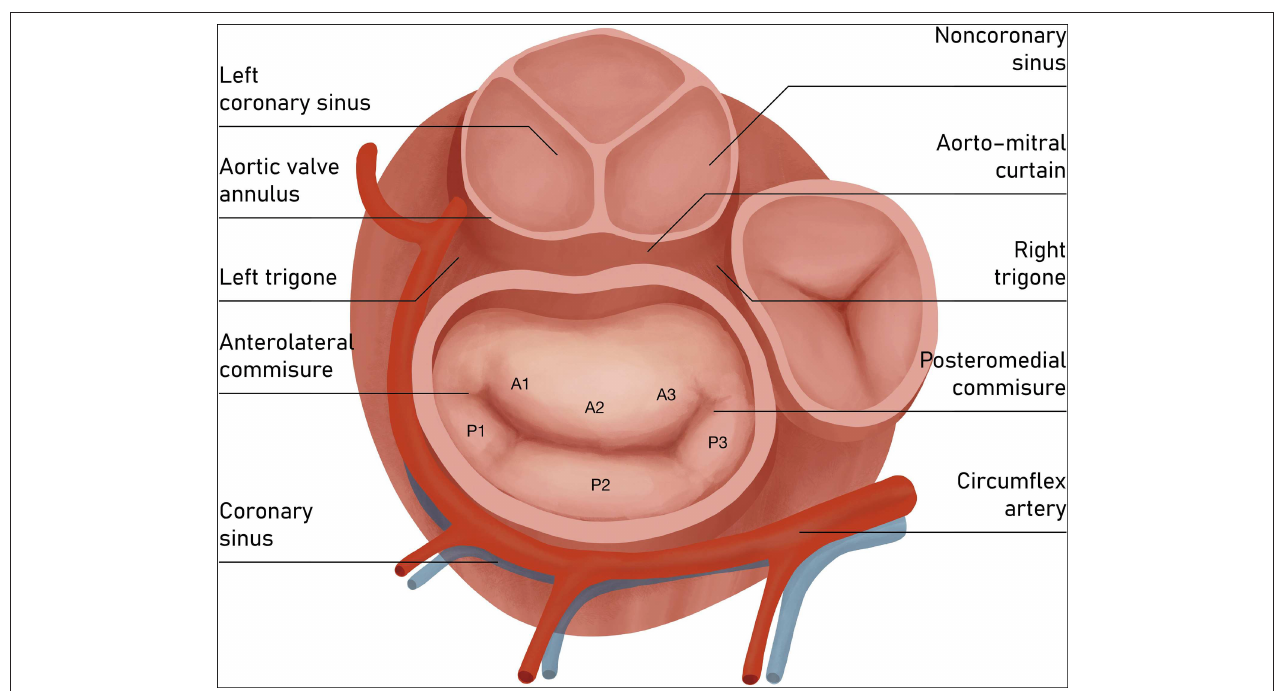
FIGURE 3 | Atrial view of mitral valve. Components of mitral valve apparatus and the adjacent structures. The posterior leaflet of the mitral valve composes ∼ 3/5 of the annular circumference and comprises three individual scallops identified as P1 (anterior or medial scallop), P2 (middle scallop), and P3 (posterior or lateral scallop). The three corresponding segments of the anterior leaflet are A1 (anterior segment), A2 (middle segment), and A3 (posterior segment).